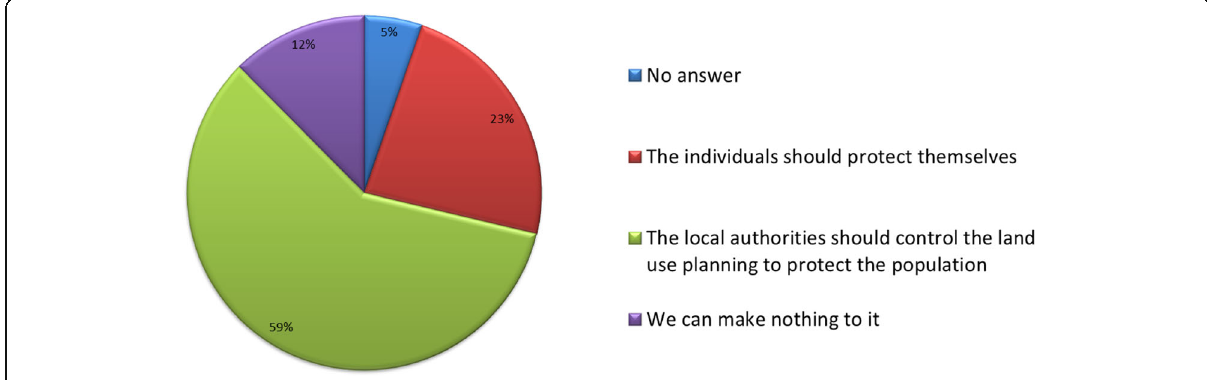
Fig. 6 Answer to the question: “ Here are several suggestions. Which is the one that is closest to your opinion about lahars? ” ( N =